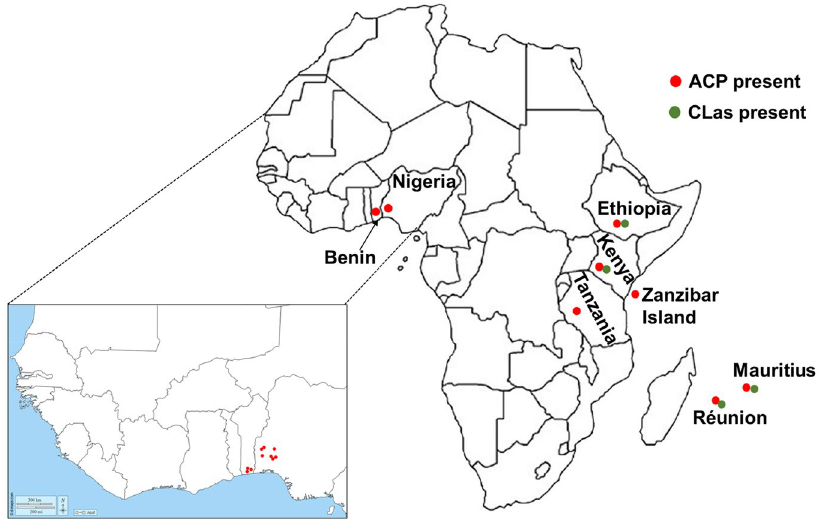
Figure 3. Map of Africa showing current incidence of the Candidatus Liberibacterasiaticus (CLas) and its Asian citrus psyllid (ACP) vector. The approximate locations where the ACP was detected in Nigeria